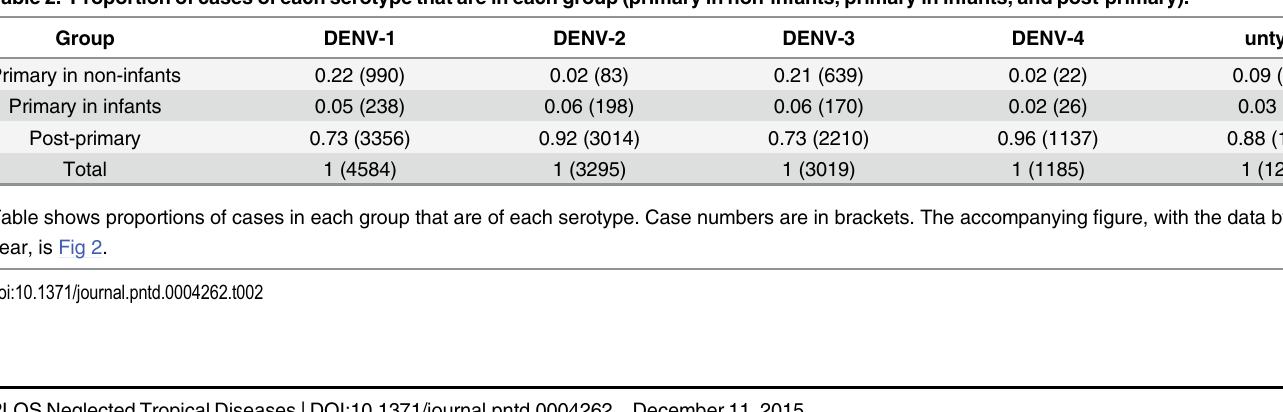
Table 2. Proportion of cases of each serotype that are in each group (primary in non-infants, primary in infants, and post-primary). Group